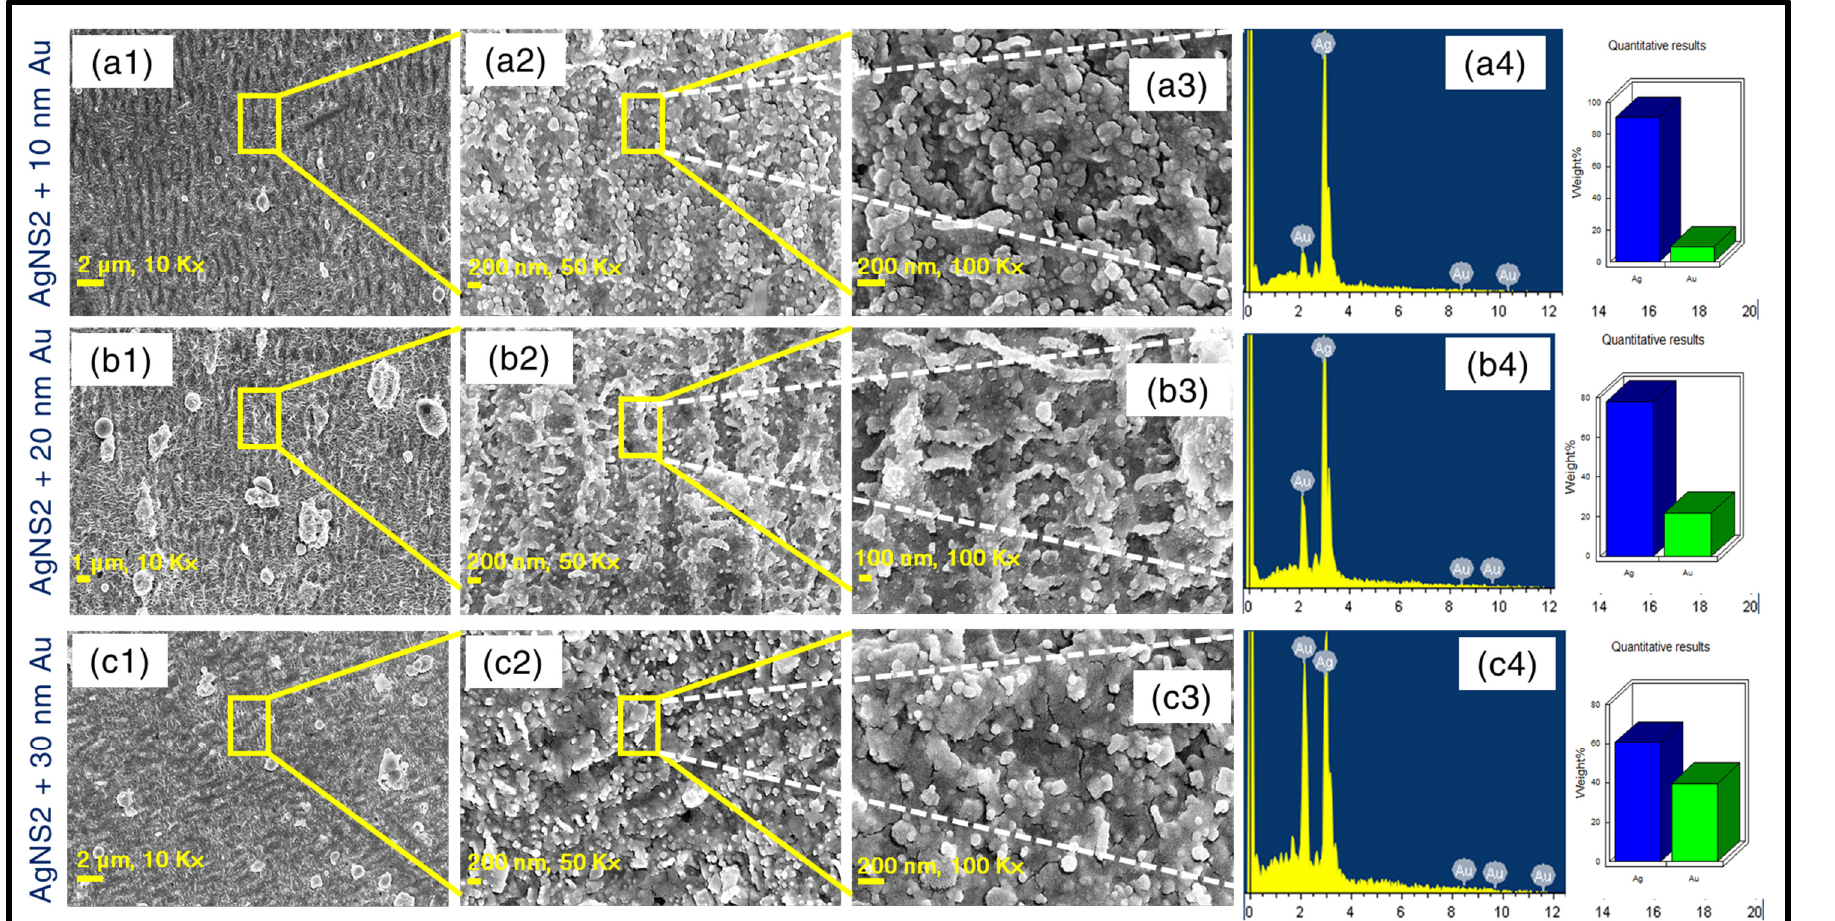
Figure 4. FESEM images along with EDX spectra for three Au coated identical AgNS2 substrates with increasing thickness of Au deposition ( a1 – a4 ) (AgNS2 + 10 nm Au) ( b1 – b4 ) (AgNS2 + 20 nm Au) and ( c1 – c4 ) (AgNS2 + 30 nm Au). For the three set of images corresponding to each Au coated-NS, figures labeled as (1), (2), (3) illustrate the FESEM images with different magnifications of 10 K×, 50 K×, 100 K×, respectively (left to right; e.g., ( a1 – a3 )). The EDX spectra are displayed in figures ( a4 , b4,c4 ) corresponding to the previous order of coated NSs. The increasing percentage of Au confirmed the increasing thickness of Au deposition.